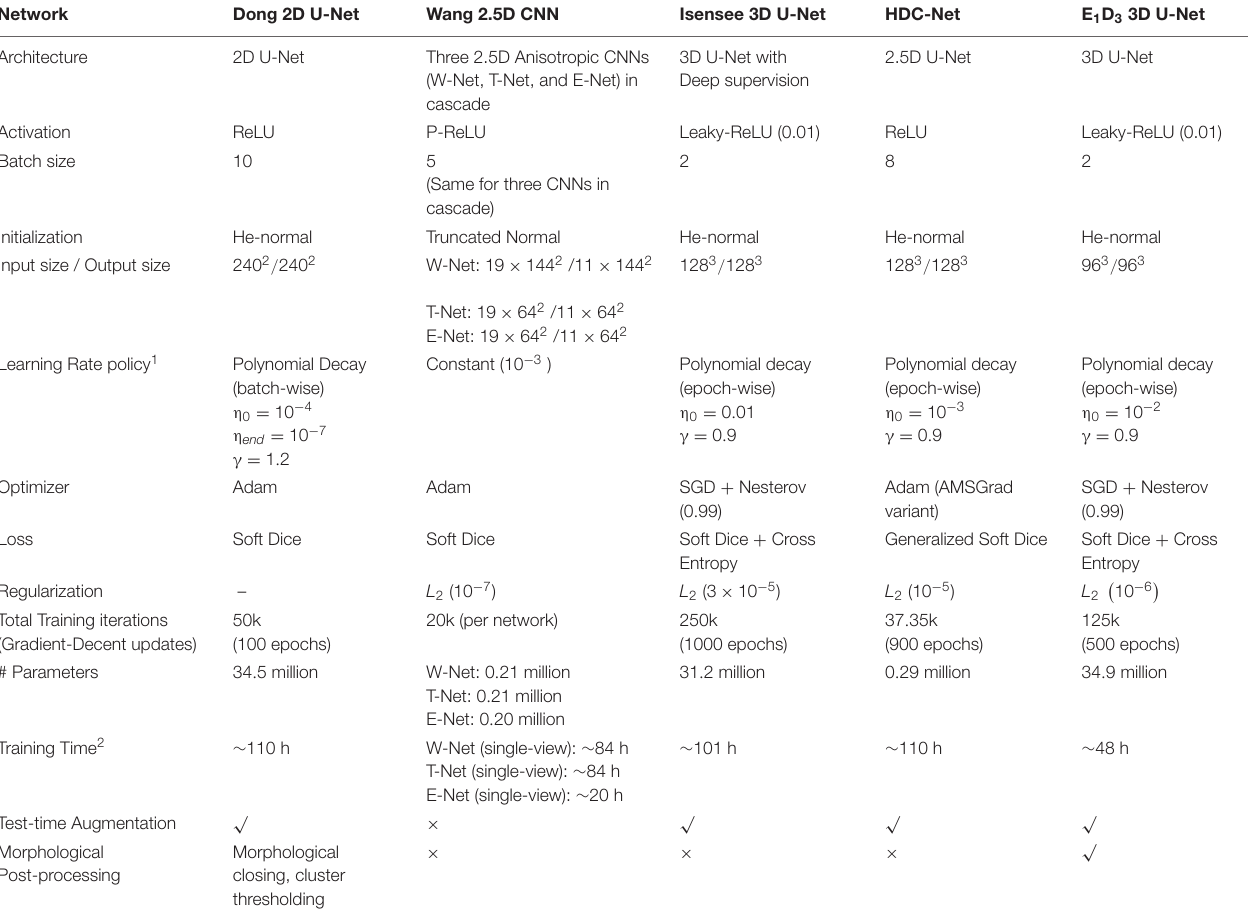
TABLE 2 | Configuration and hyperparameters of five CNNs used for automatic segmentation of brain tumor